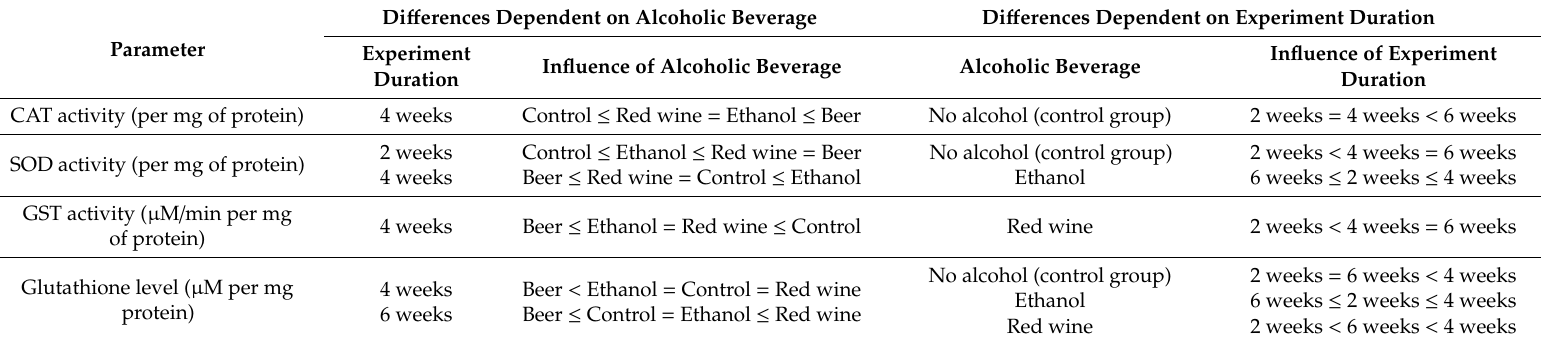
Table 13. The summary of observed influence of the alcoholic beverage and experiment duration on the assessed